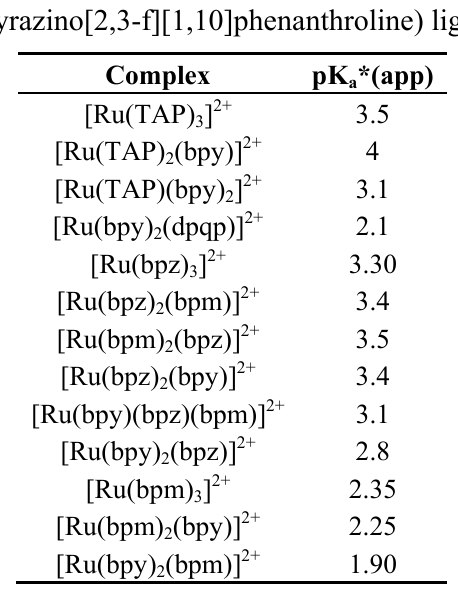
Table 1. Apparent excited state pKa for various complexes bearing bpy (2,2'-bipyridine), bpm (2,2'-bipyrimidine), bpz (2,2'-bipyrazine), TAP (1,4,5,8-tetraazaphenanthrene)